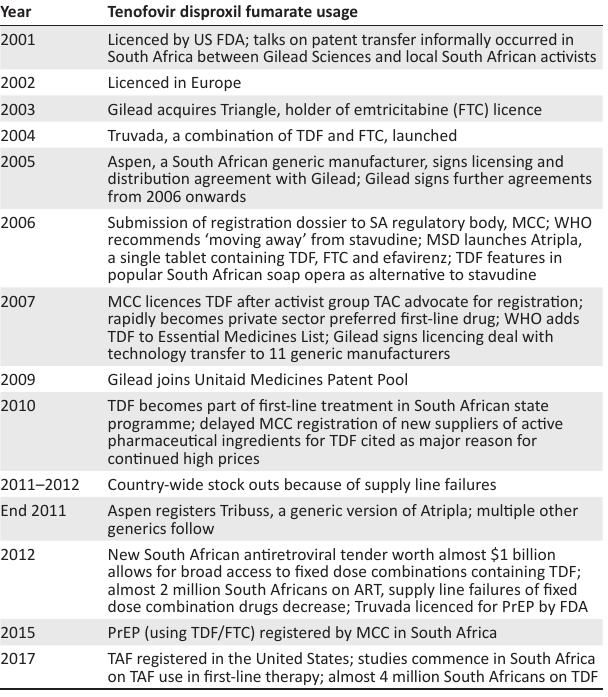
TABLE 1: Tenofovir disproxil fumarate usage timeline in South Africa.